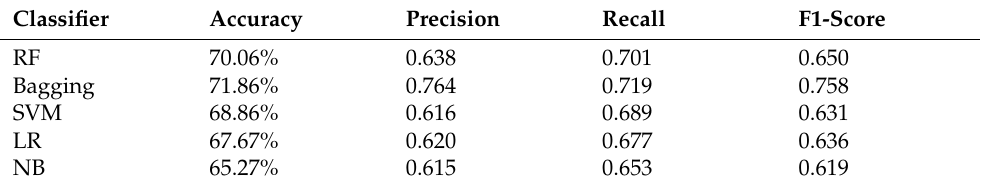
Table 21. Experiments with ML models and Bing Lui + AFINN lexicons on the TextBlob